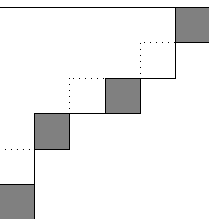
Table 1 . Convention of notations related to Young diagram.